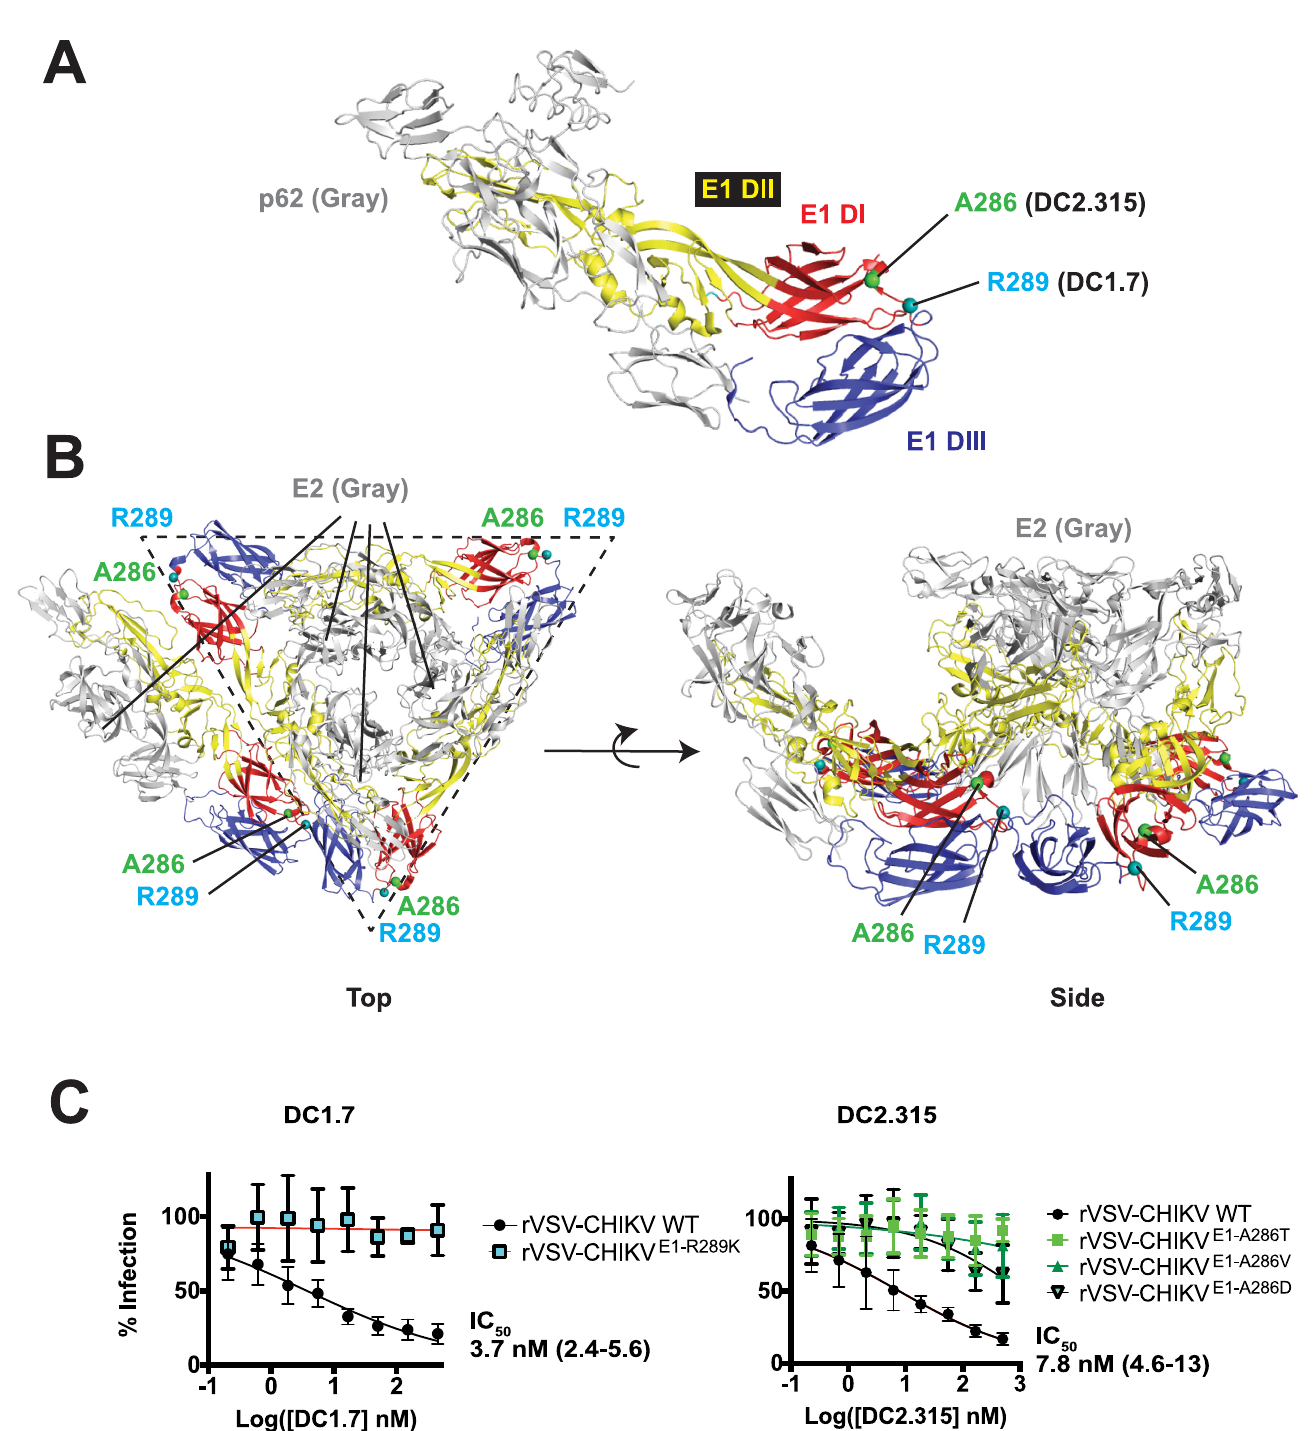
Fig 5. Viral escape studies with E1-targeting mAbs. Location of A286 and R289 on the p62-E1 X-ray structure ( A , PDB ID: 3N40) [9] or on the E1/E2 cryoEM heterohexamer ( B , PDB ID: 3J2W) [11]. For clarity, p62 or E2 subunits are colored gray whereas E1 domains DI, DII, and DIII colored as per Fig 1 . In panel B, a complete prefusion E1/E2 hexameric spike (outlined with dotted line) is illustrated, along with an E1/E2 heterodimer from an adjacent spike, to depict relative orientation within adjacent spikes. ( C ) Neutralization studies with WT VSV-CHIKV and viral escape mutants. Data are pooled from two experiments, each performed in duplicate or triplicate (points represent mean ±